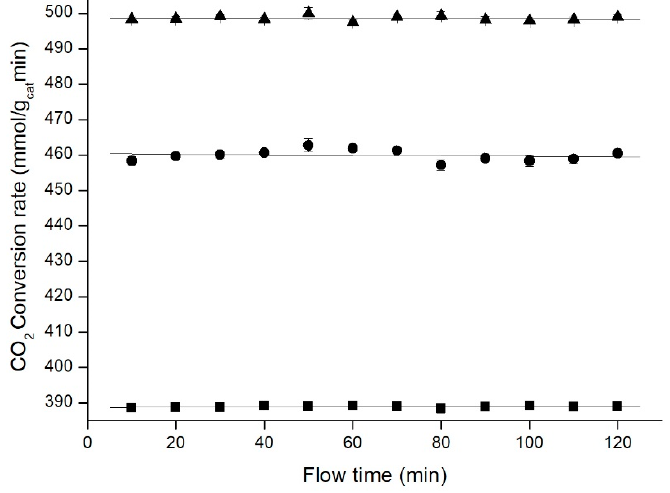
Figure 12. CO 2 hydrogenation at high pressures (50 bar ■ , 80 bar •, 100 bar ▲ ). Data points represent the average of 3 experiments, with error bars corresponding to confidence interval 95%.